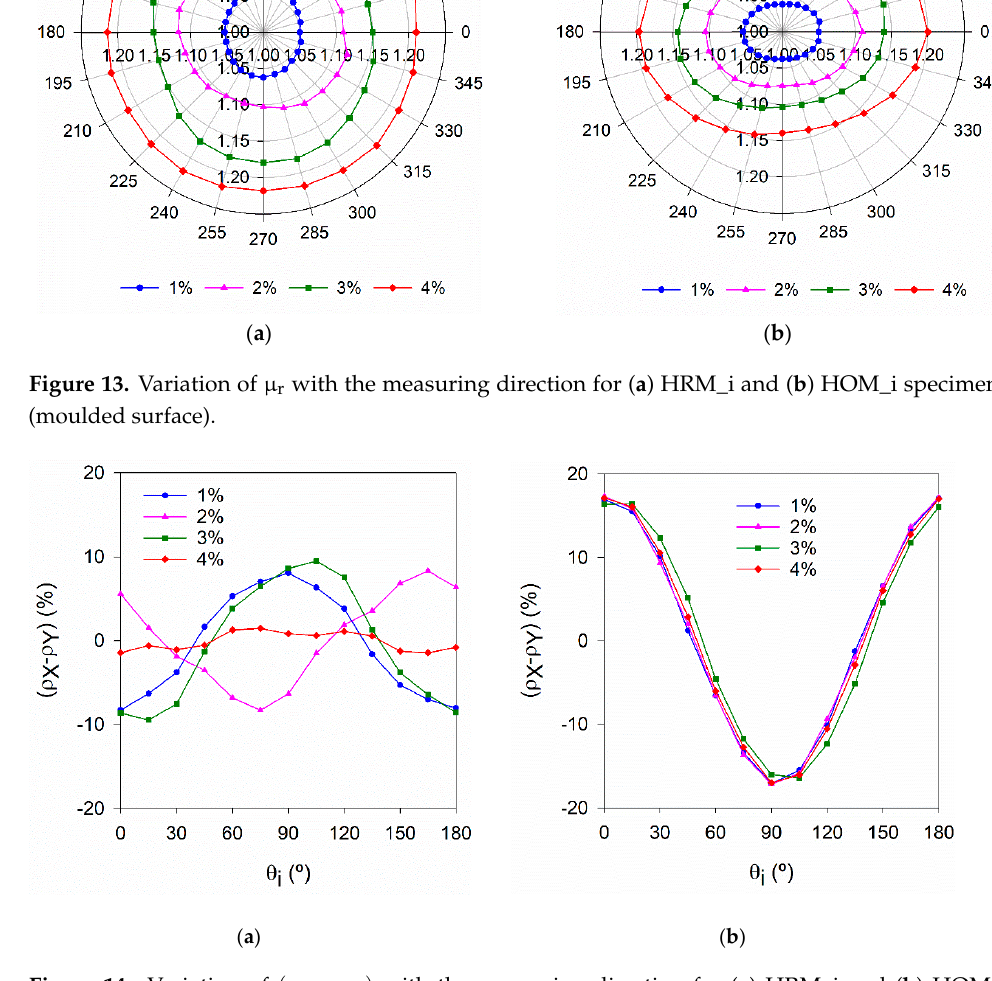
Figure 14. Variation of ( ρ X − ρ Y ) with the measuring direction for ( a ) HRM_i and ( b ) HOM_i specimens (moulded surface).